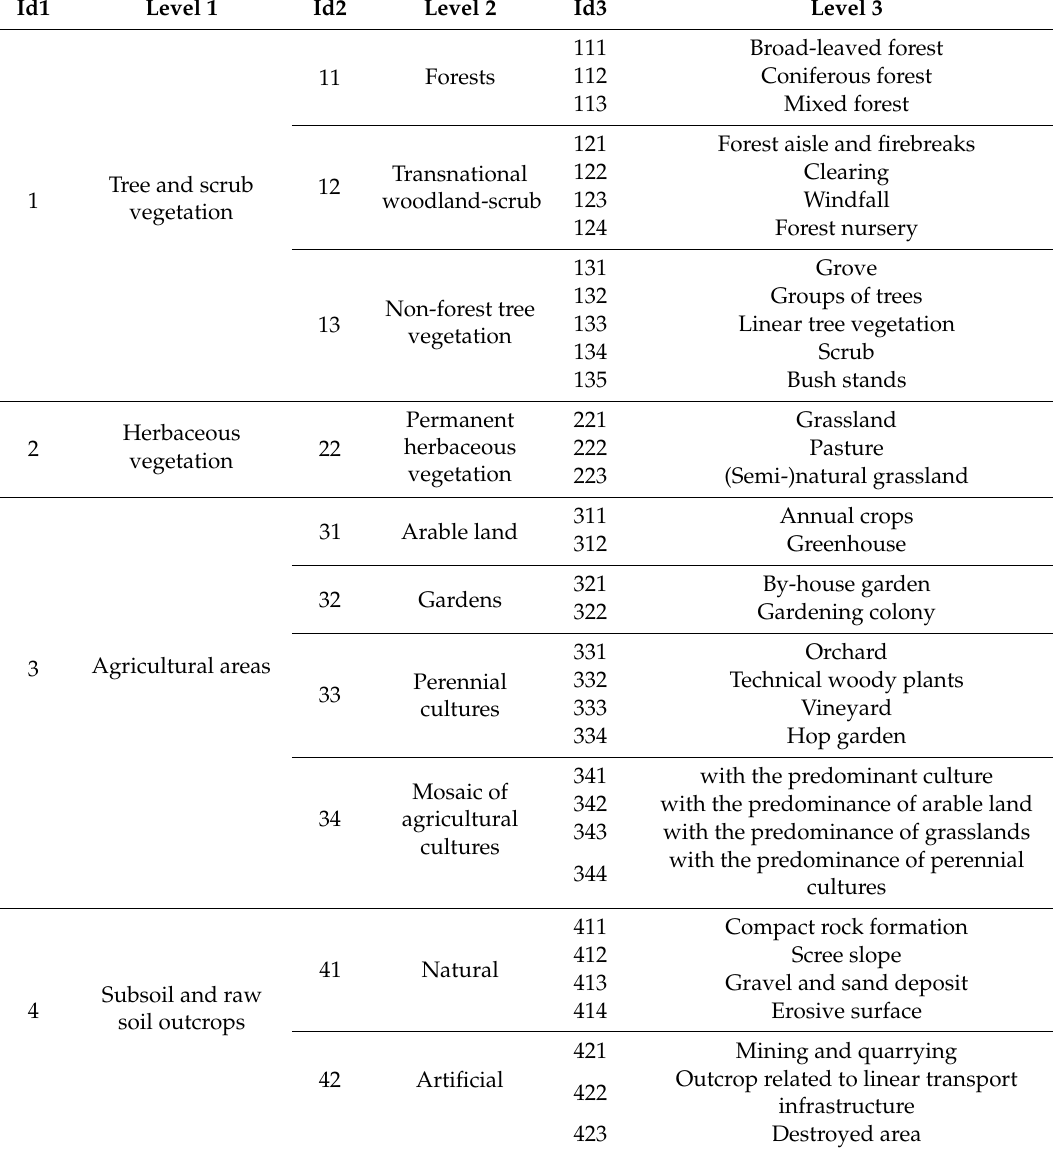
Table A1. The secondary landscape structure elements as classified by Petroviˇc, Bug á r, Hreško